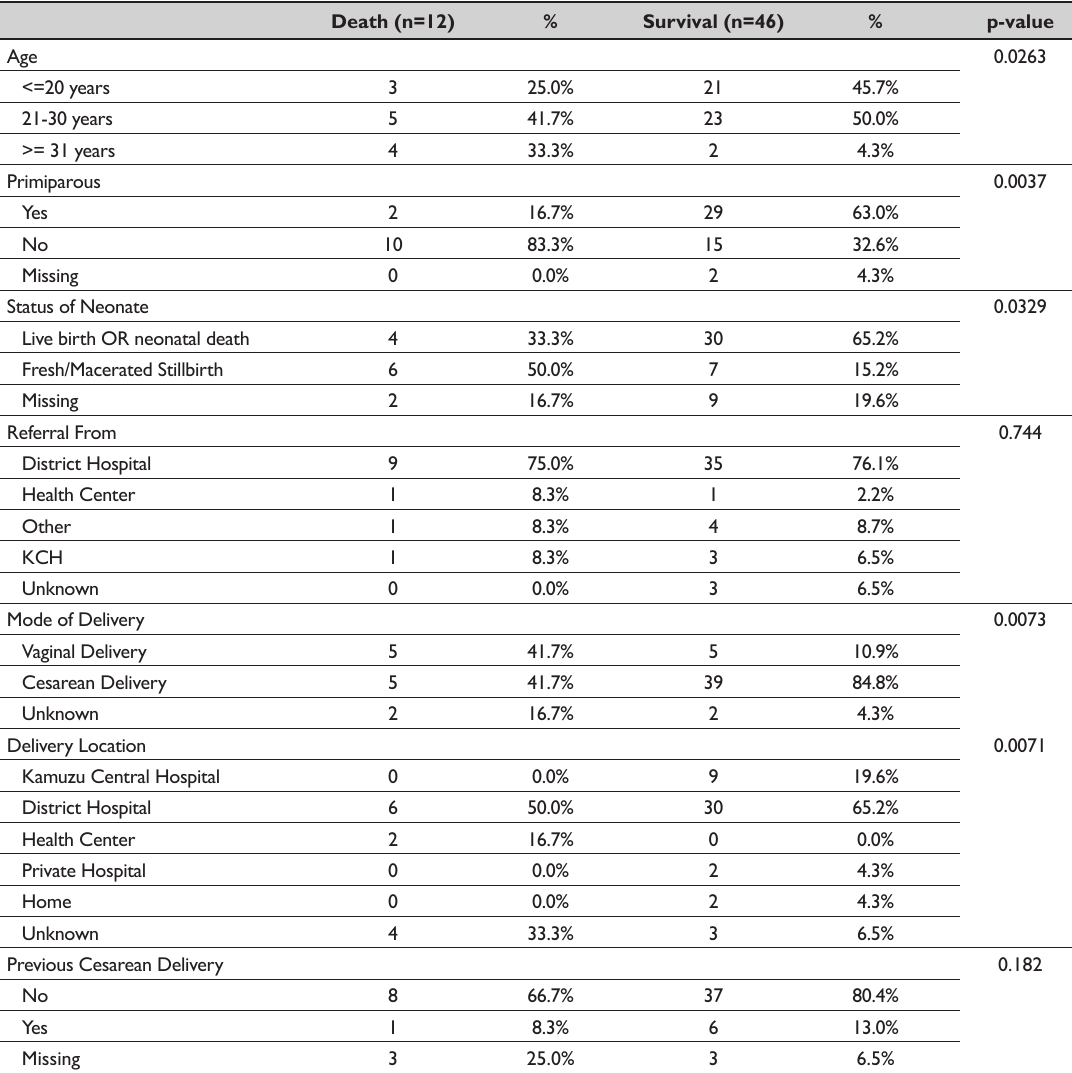
Table 1: Demographic and admission variables: death vs.